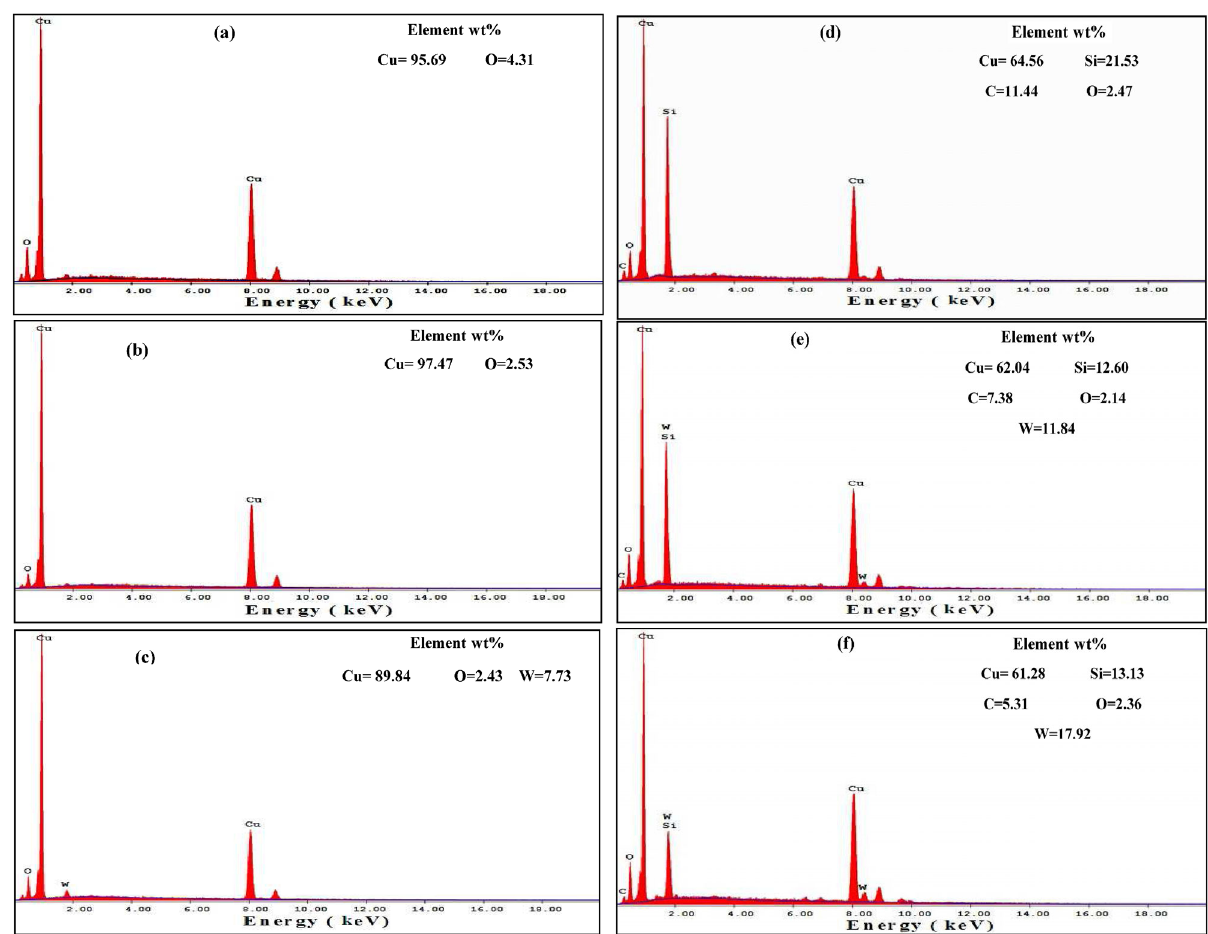
Fig. 11 EDS analysis of worn surface of (a–c) Cu and (d–f) Cu-20%SiC cold compacted (a and d), sintered (b and e), and HPTed samples (c and f) corresponding to a sliding distance of 2,500 m and an applied load of 30